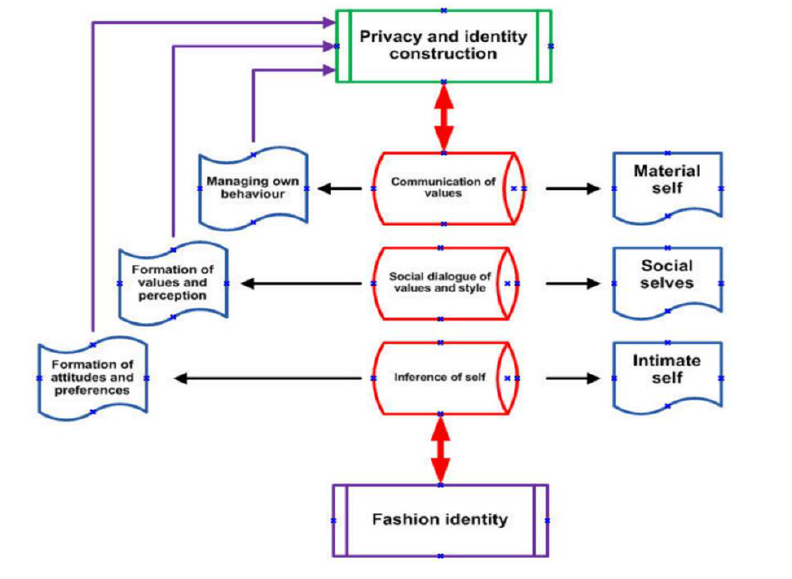
Figure 1. On privacy considering fashion